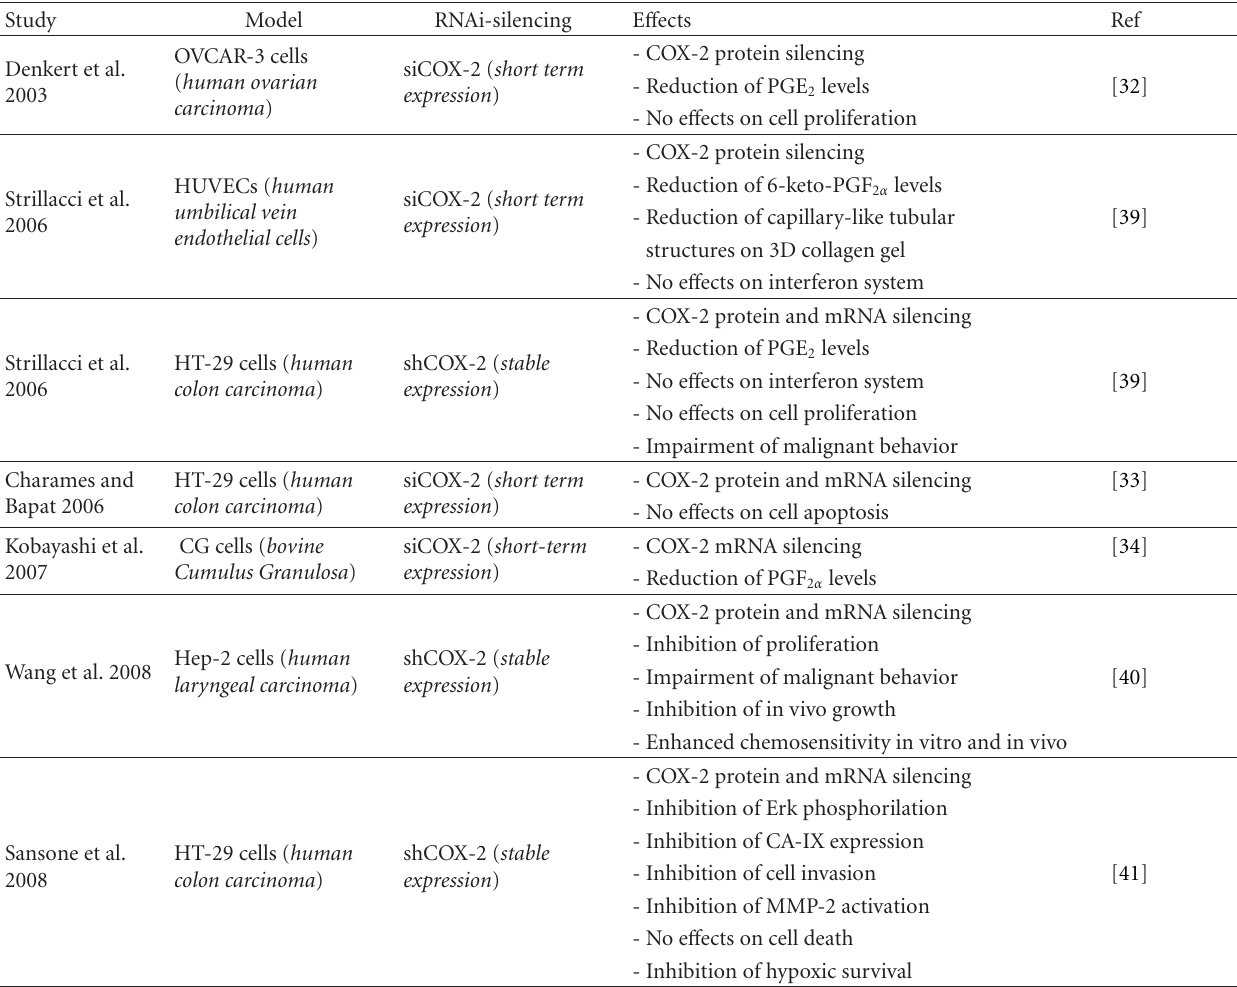
Table 1: COX-2 silencing mediated by